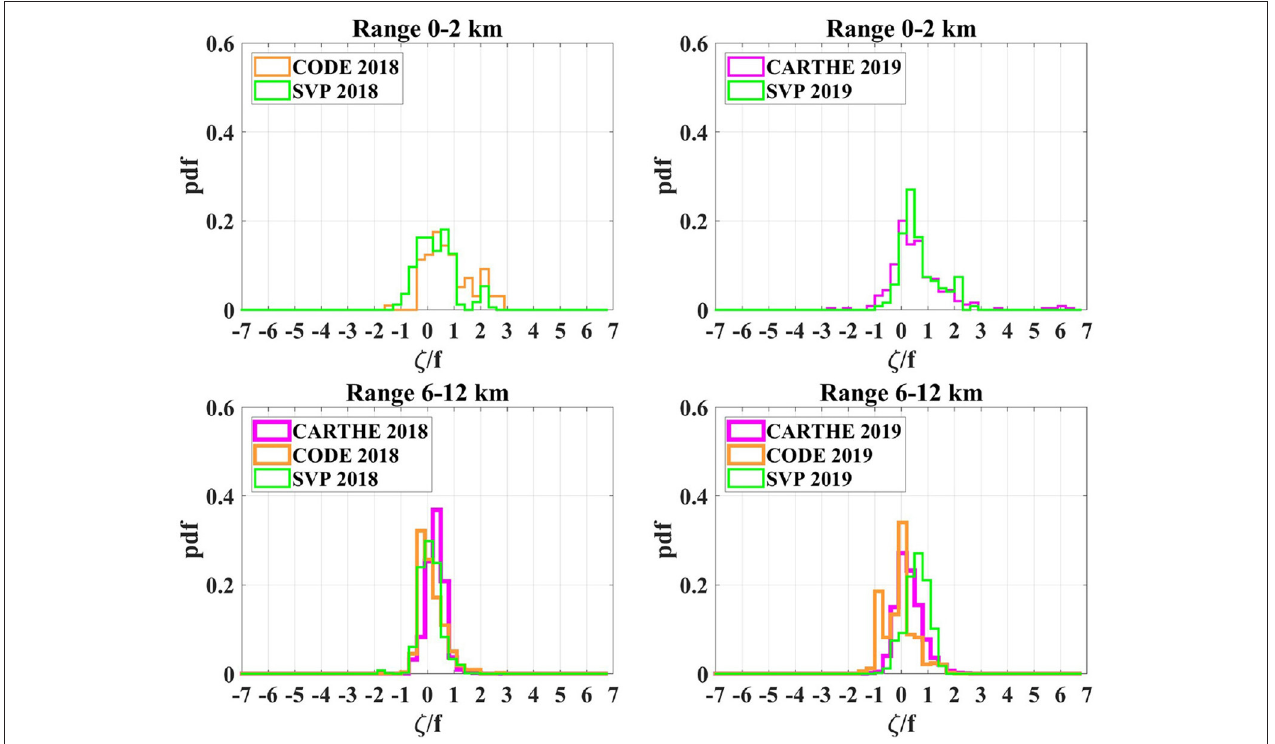
FIGURE 7 | Distribution of normalized vorticity estimates for the 3 types of drifter (magenta for CARTHE, orange for CODE, and green for SVP) during the experiments 2018 (left) and 2019 (right) calculated from drifter triplets in the ranges: < 2 km (upper) and (6–12) km (lower) .